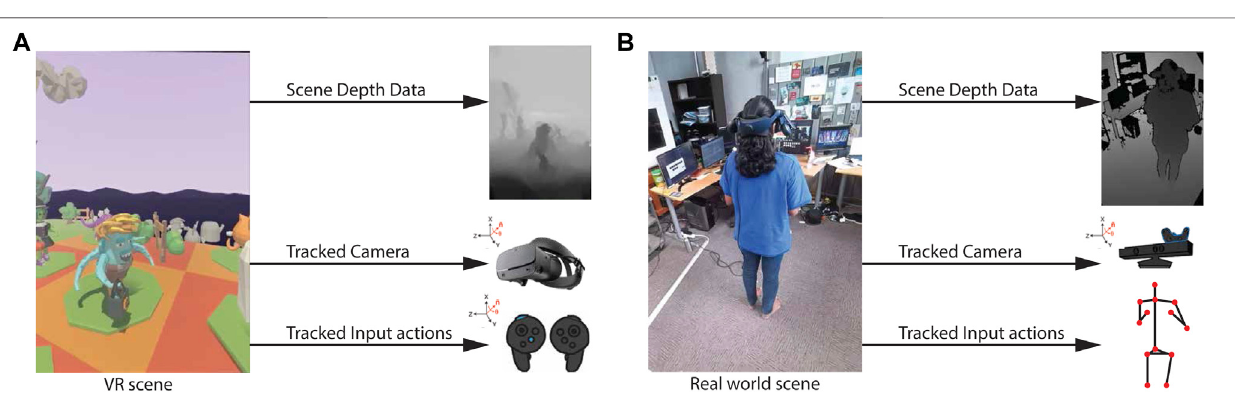
FIGURE7| Analogousdatacapturedinvirtualandphysicalworlds.(Left)InVR,VRsceneimagecorrespondingdepthtexture,poseofVRHMD(camera)aswellas the VR user ’ s input pose and actions are captured. (Right) In physical world, besides the scene image, depth data, tracked pose of the depth camera as well as their actions (through skeletal tracking) are